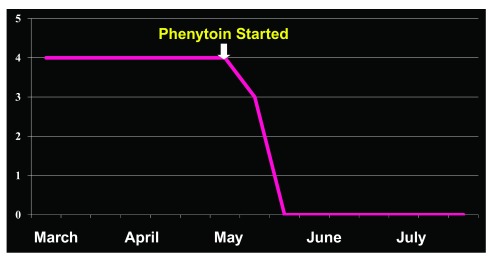
Hypersexuality in Klüver–Bucy syndrome before/after intravenous phenytoin.Changes in overeating and sexual behaviors in a 65-year-old male patient with nonconvulsive status epilepticus manifesting as Klüver–Bucy syndrome. Hypersexuality decreased immediately after the initiation of phenytoin therapy and completely disappeared two weeks later. Overeating also disappeared but was followed by severe anorexia.